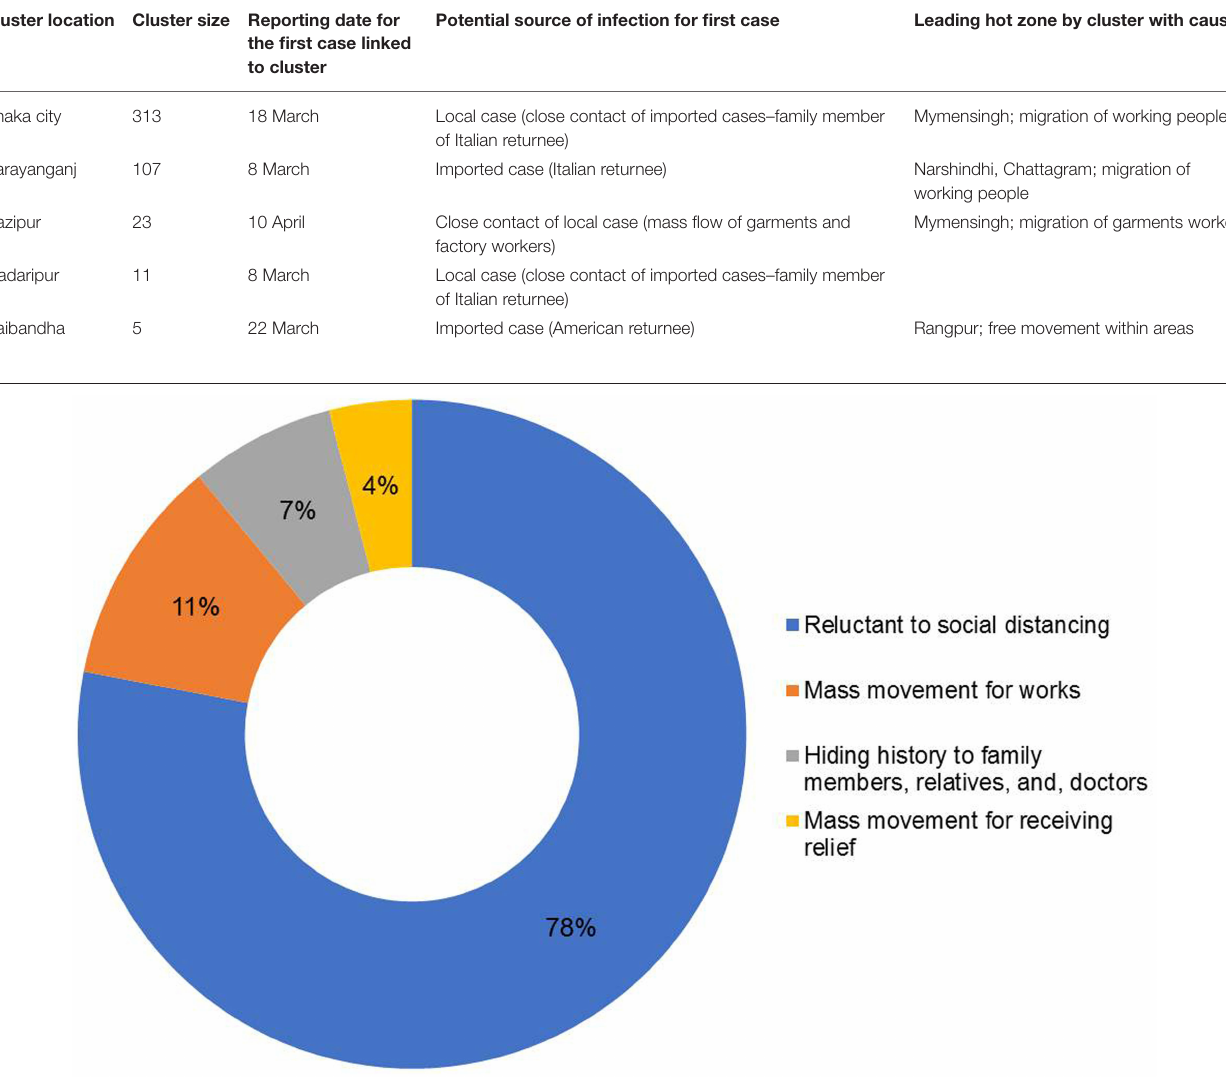
FIGURE 7 | Factors facilitating the transmission of COVID-19 in Bangladesh on the basis of public